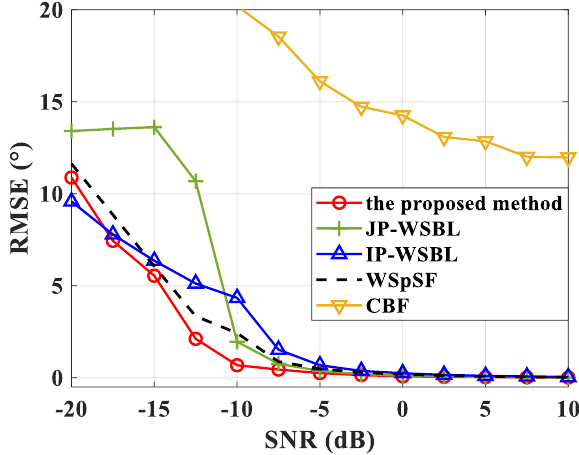
Figure 7. The RMSE versus the SNR under Case III.